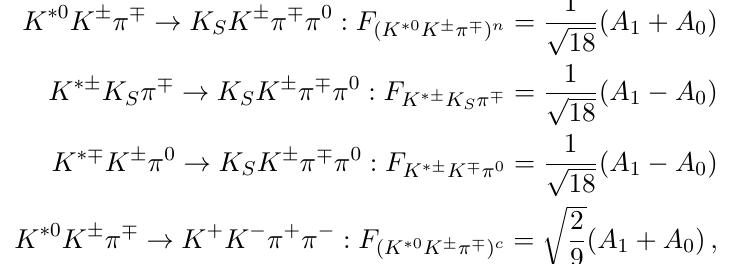
and A amplitudes, respectively. 0 1